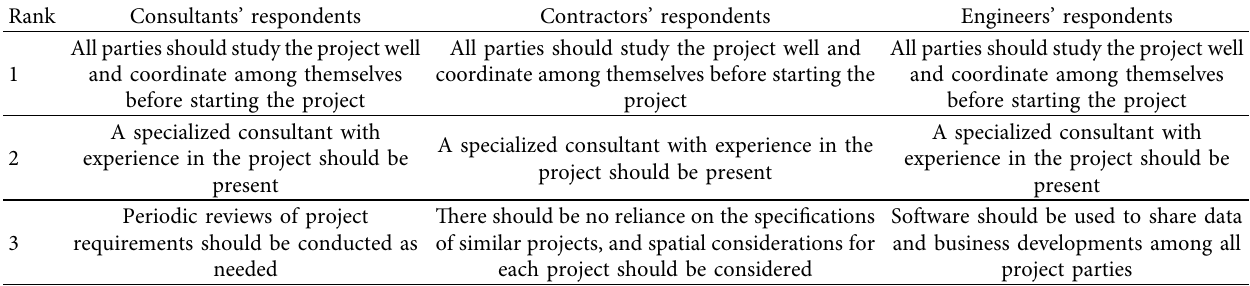
Table 9: )e most important factors that mitigate the impacts of change orders on construction